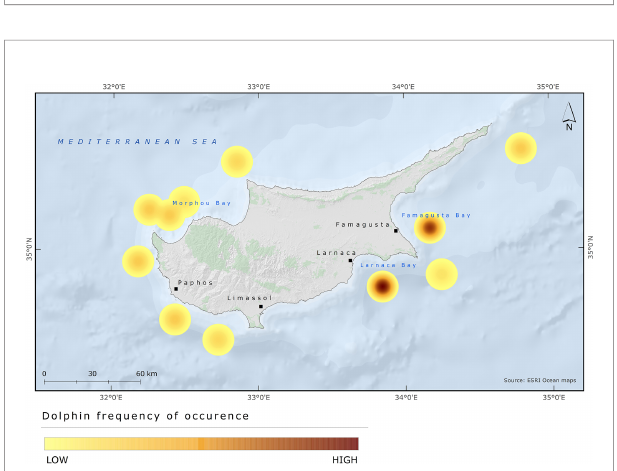
FIGURE 10 | Bycatch of a juvenile Stenella coerueoalba on pelagic longlines targeting sword fi sh in September 2021. Photograph taken onboard by the vessel ’ s captain.